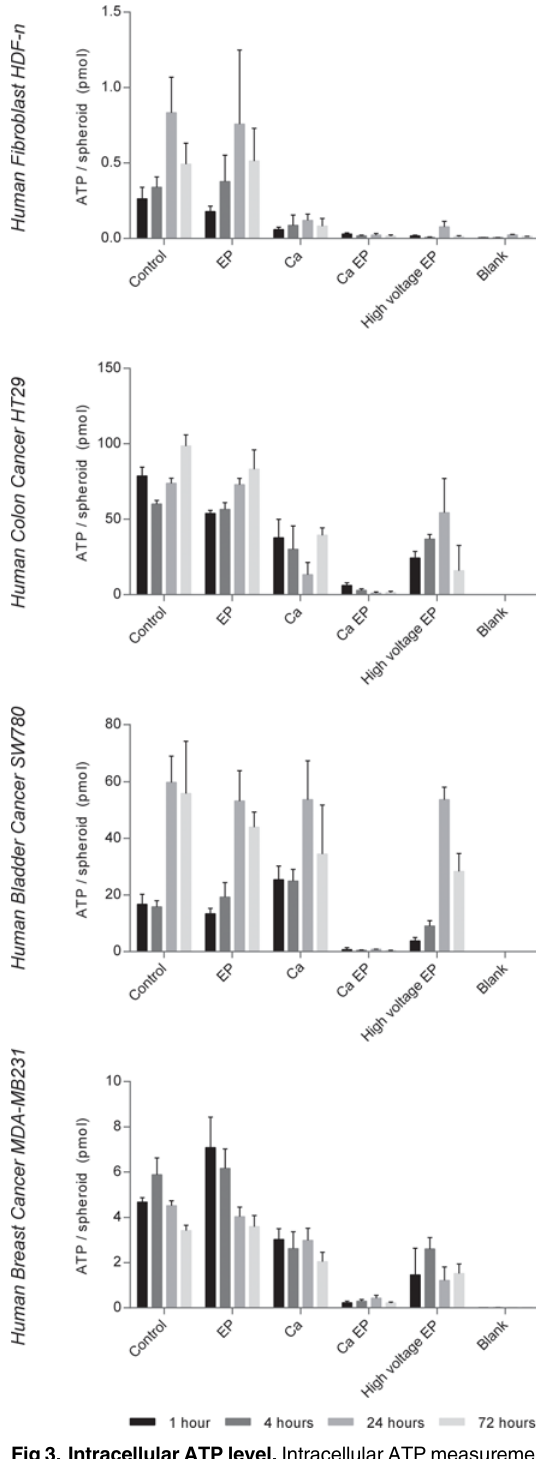
Fig 3. Intracellular ATP level. Intracellular ATP measurements of human normal dermal fibroblast, colon cancer, bladder cancer, and breast cancer spheroids 1, 4, 24, and 72 hours after treatment with 168 mM calcium (Ca), electroporation (EP; 8 pulses of 100 μ s, 1000 V/cm, and 1 Hz), 168 mM calcium electroporation (Ca EP), high voltage EP (8 pulses of 100 μ s, 5000 V/cm, and 1 Hz), and of untreated controls (Control). Means + SD, n = 3 – 5 (n = 2 for blank). Please note the difference in the y-axes.